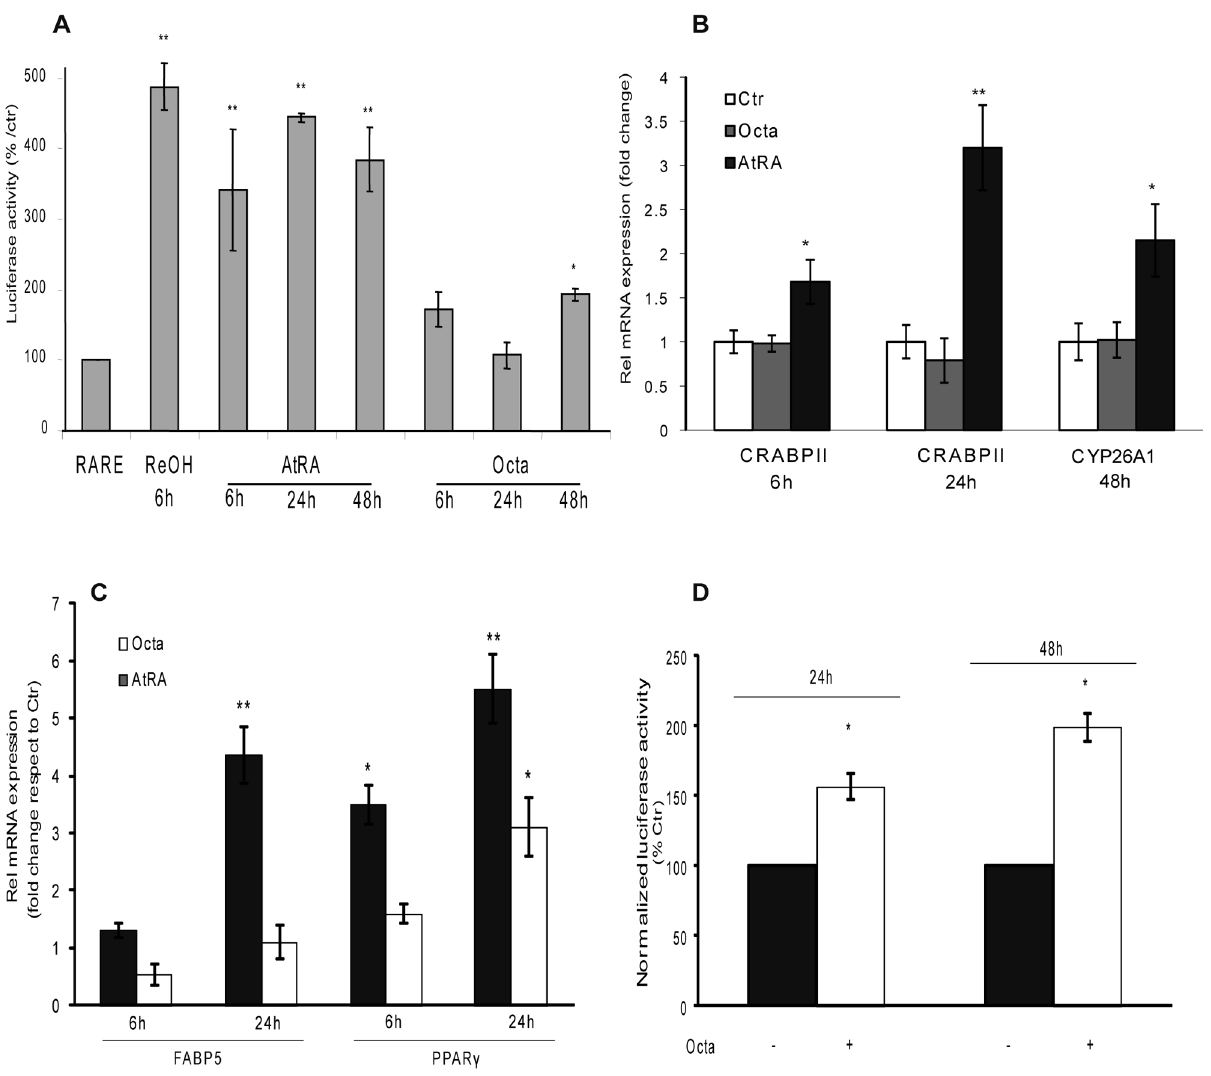
Figure 1. Evidence for Octa-mediated activation of PPAR c -linked signal transduction. (A) Activation of RARE. Cells (2 6 10 4 cells/well) were plated in a 24-well plate and after 24 h they were transfected with RARE. After 24 h, cells were treated with 5 m M ReOH for 6 h, 5 m M AtRA for 6–48 h, and 2 m M Octa for 6–48 h. Measurement of luciferase activity was assessed as reported in Materials and Methods . (B) Quantitative real-time RT-PCR was performed to measure the expression of CRABPII and CYP26A1 mRNA at various time points after treatment with 2 m M Octa or 5 m M AtRA. The values were normalized to GAPDH mRNA levels. (C) Quantitative real-time RT-PCR was performed to measure the expression of FABP5 and PPAR c mRNA at various time points after treatment with 2 m M Octa or 5 m M AtRA. The values were normalized to GAPDH mRNA levels. (D) Luciferase activity analysis of cells transfected with pGL3-(Jwt)3TKLuc reporter construct. After 24 h of transfection, cells were treated with 2 m M Octa. The measurement of luciferase activity was carried out 24 h and 48 h after treatment. *p , 0.05; **p , 0.001 respect to untreated control